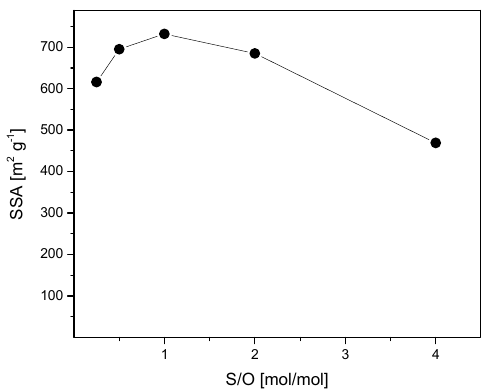
Figure 3. Specific surface area (SSA) of the membrane materials (5% Al 2 O 3 –doped a -silica) as a function of the surfactant / oxide molar ratio (S / O) in the reaction mixture.